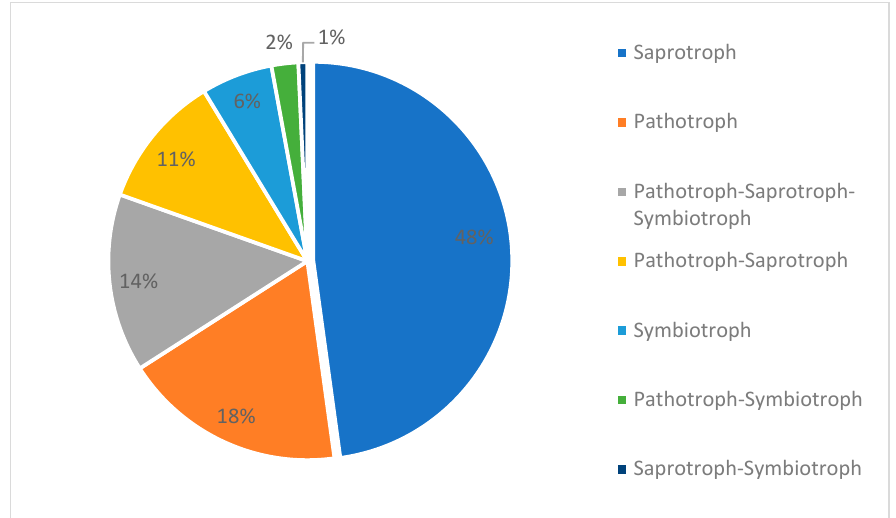
Figure 2. Relative frequency of the mycorrhizal and root-associated endophytic fungal OTUs corresponding to the different trophic guilds as assigned by FunGuild.